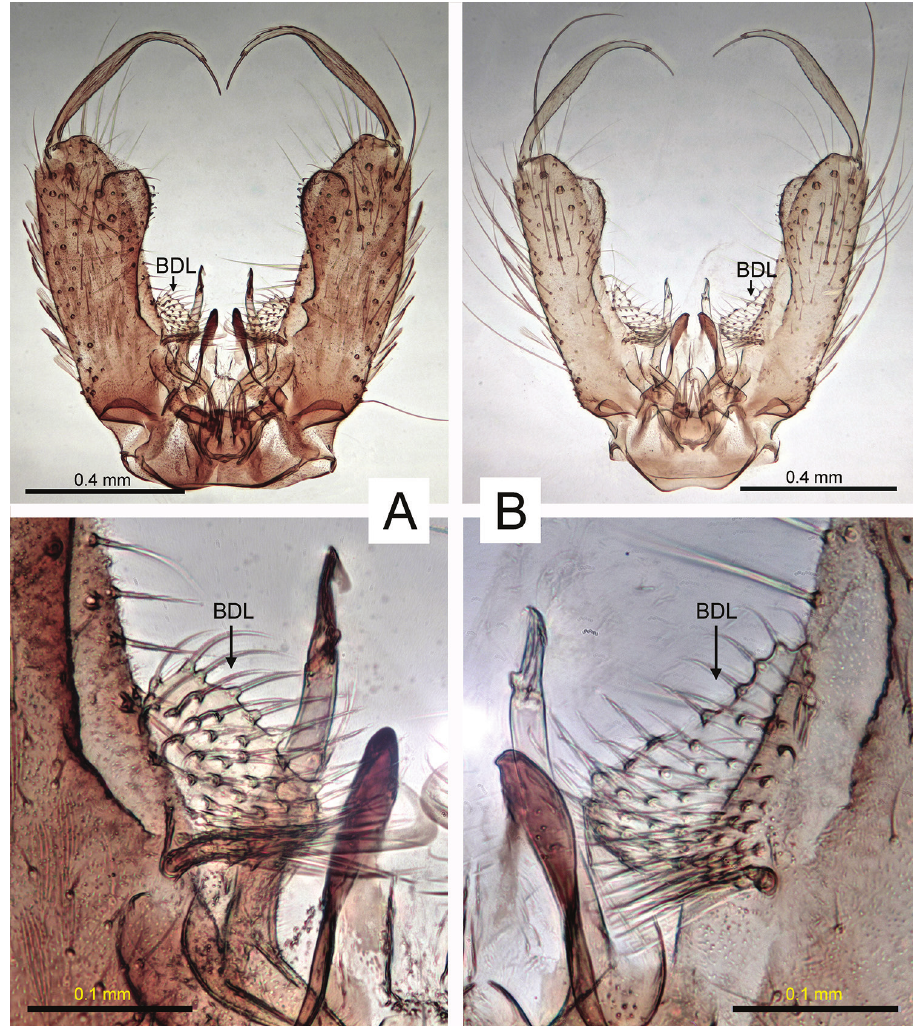
Figure 2. Doral aspects (pre-rotation sense) of the male genitalia of Ae. nigrinus ( A ) and Ae. sticticus ( B ), which are distinguished by the shape of the basal dorsomesal lobe